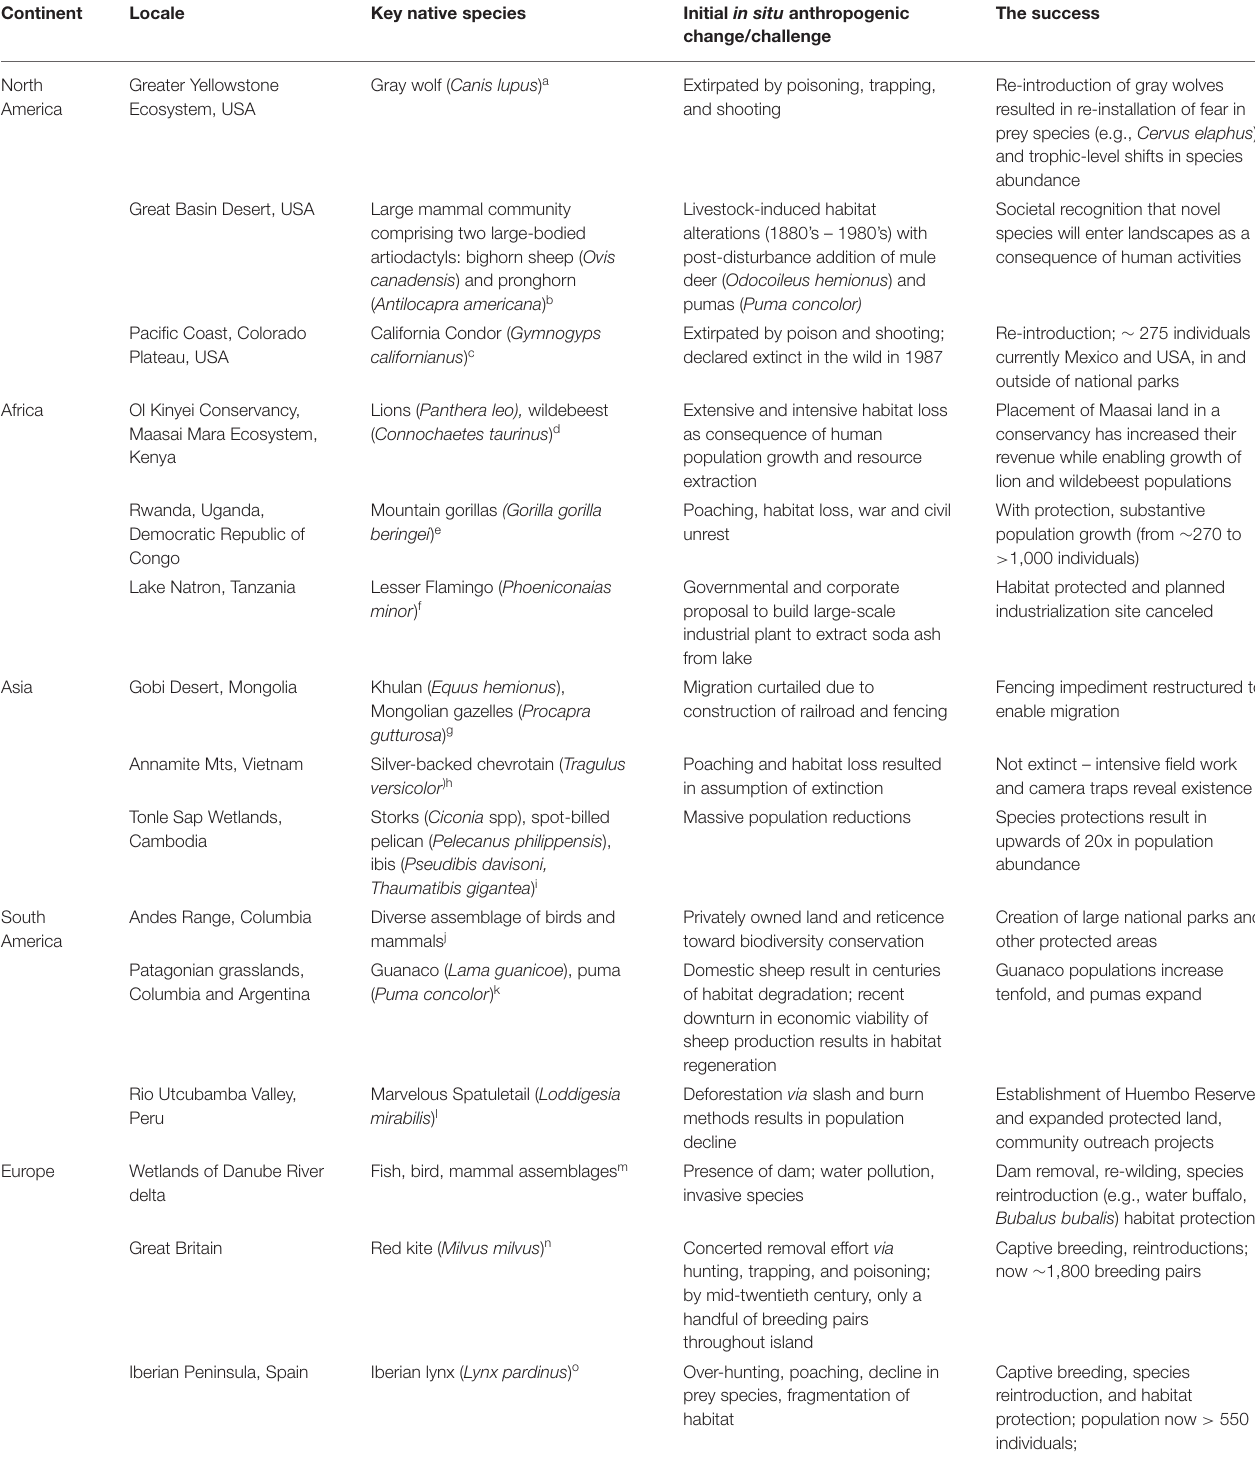
TABLE 1 | Exemplars of conservation success at species or ecological process levels on each of